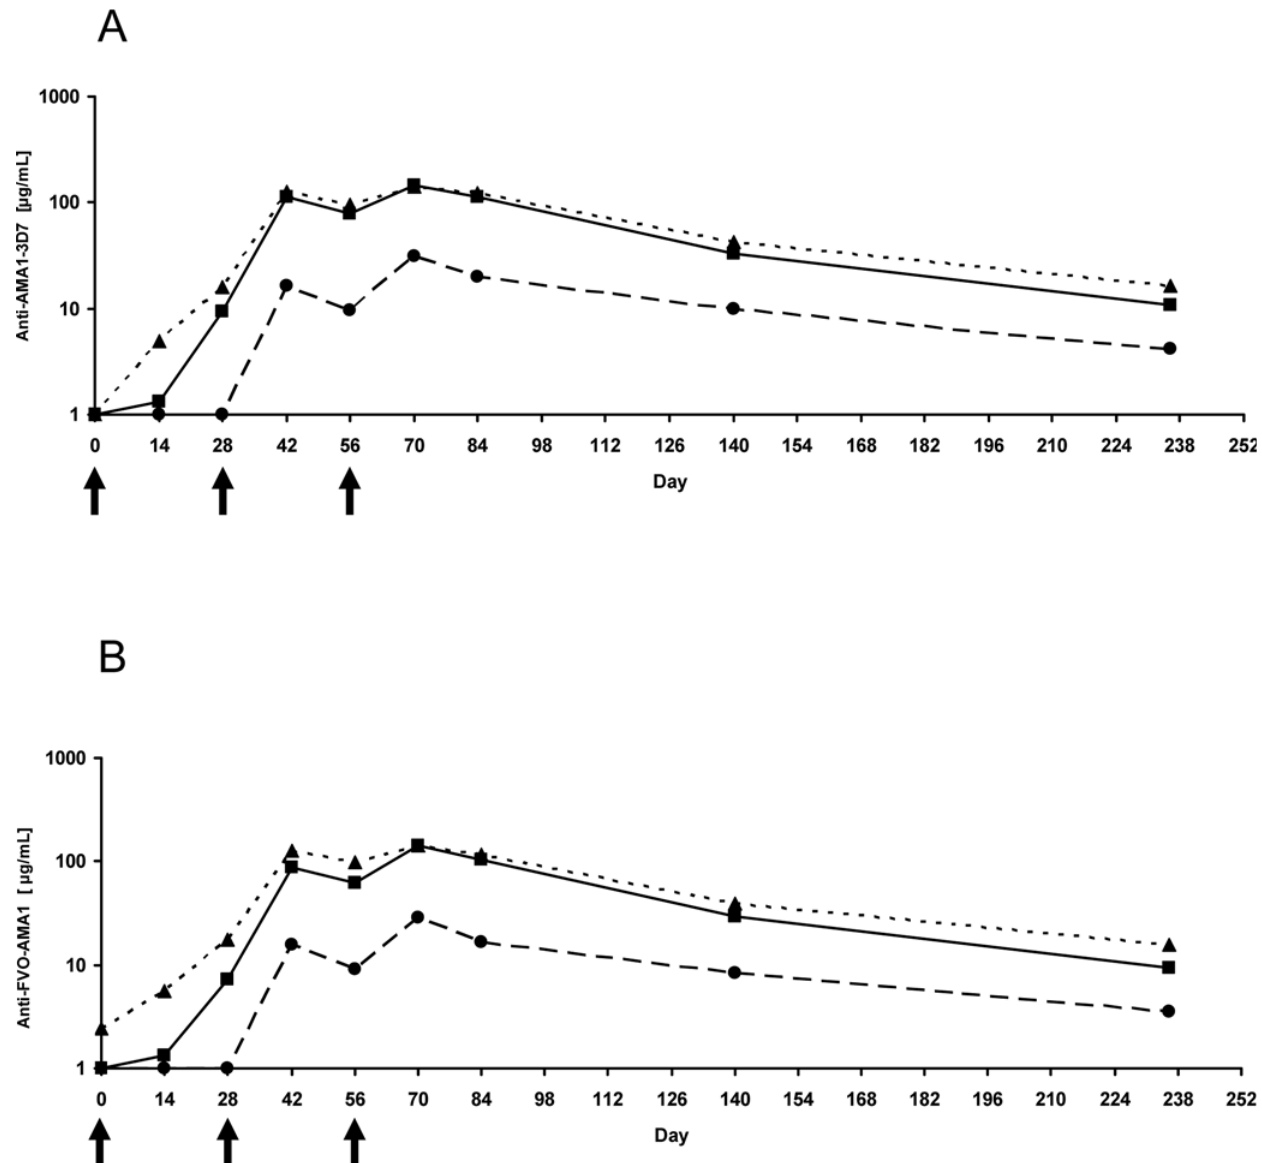
Figure 3. Longevity of antibody responses: AMA1 antibody responses in recipients of the 20 or 80 m g AMA1-C1/Alhydrogel 6 CPG 7909 vaccines. Antibody responses against AMA1-3D7 (A) and AMA1-FVO (B) measured by ELISA in sera collected on Day 0 through to Day 236. ELISA results are shown as the geometric mean of AMA1-specific antibody ( m g/mL). The lines represents 80 m g AMA1 (black circles/dashed line), 20 m g AMA1 + CPG (black squares/solid line), and 80 m g AMA1 + CPG (black triangles/dotted line). Arrows indicate the days of